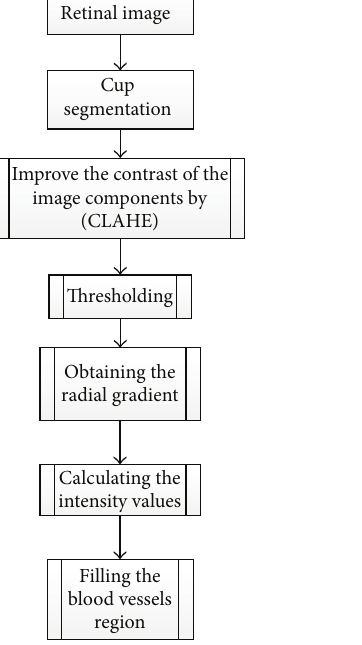
Figure 24: Flowchart for algorithm proposed in [55].